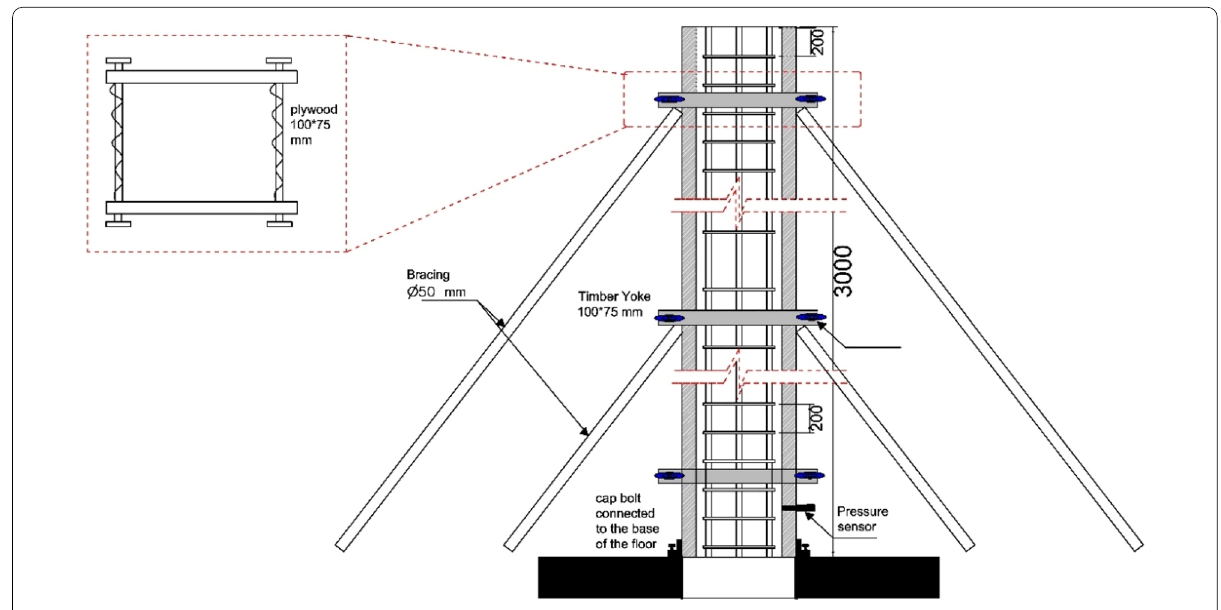
= 23.4 × H m , into a higher-dimensional feature space with linearly sep-